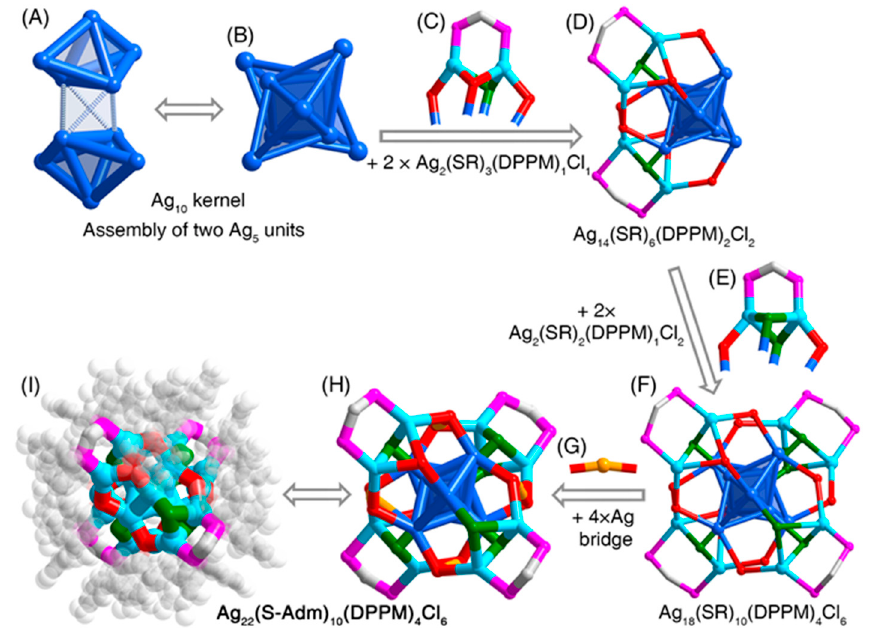
Figure 1. Structural anatomy of the Ag 22 -L1 nanocluster. ( A , B ) The Ag 10 kernel, constituted by assembling two Ag 5 units. ( C ) Two Ag 2 (S-Adm) 3 (DPPM) 1 Cl 1 surface units. ( D ) The Ag 14 (S-Adm) 6 (DPPM) 2 Cl 2 structure. ( E ) Two Ag 2 (S-Adm) 2 (DPPM) 1 Cl 2 surface units. ( F ) The Ag 18 (S-Adm) 10 (DPPM) 4 Cl 6 structure. ( G ) Four Ag bridges. ( H , I ) Overall structure of the Ag 22 (S-Adm) 10 (DPPM) 4 Cl 6 nanocluster. Color codes: blue/light blue/orange sphere, Ag; red sphere, S; magenta sphere, P; green sphere, Cl; grey sphere, C; white sphere, H.